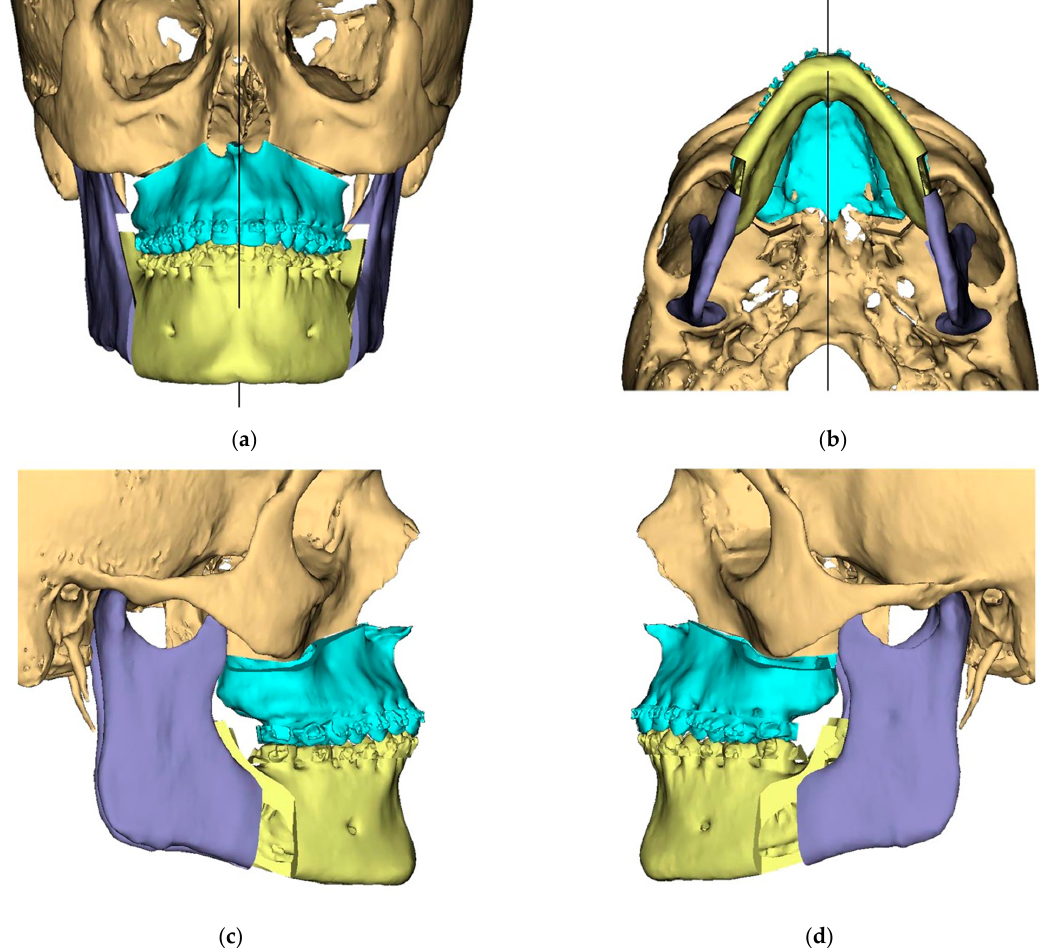
Figure 3. Surgical Plan: Final Position—Mandible moved according to planned maxilla position (Proximal segments rotated in) ( a ) Frontal view; ( b ) Occlusal view; ( c ) Right side view; ( d ) Left side view.